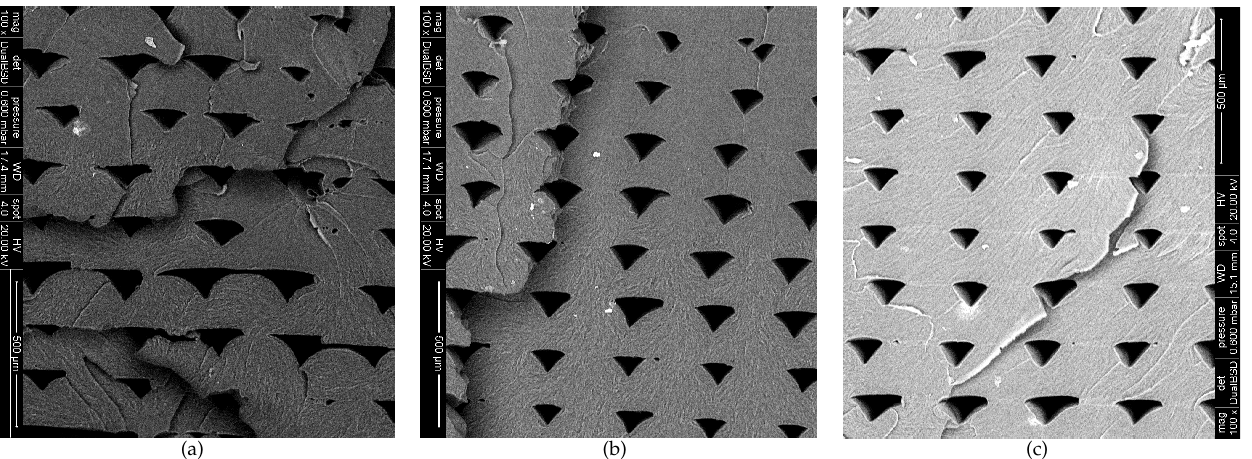
Figure 7. SEM micrographs of the ME-AM sample fracture cross-sections for 3 printing speeds. ( a ) v p = 5 mm/s; ( b ) v p = 20 mm/s; ( c ) v p = 35 mm/s.